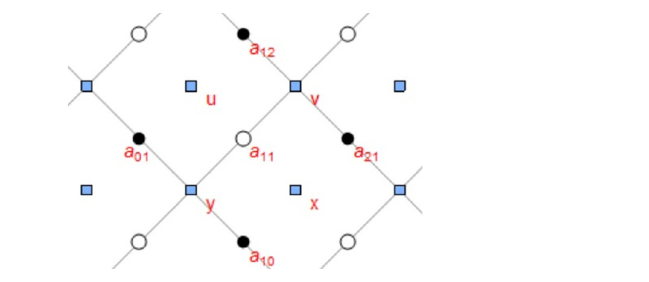
Figure 4 . Subdivided lattice. The discrete a field has been extended to the vertices ( y, v ) and to the centers of plaquettes ( x, u